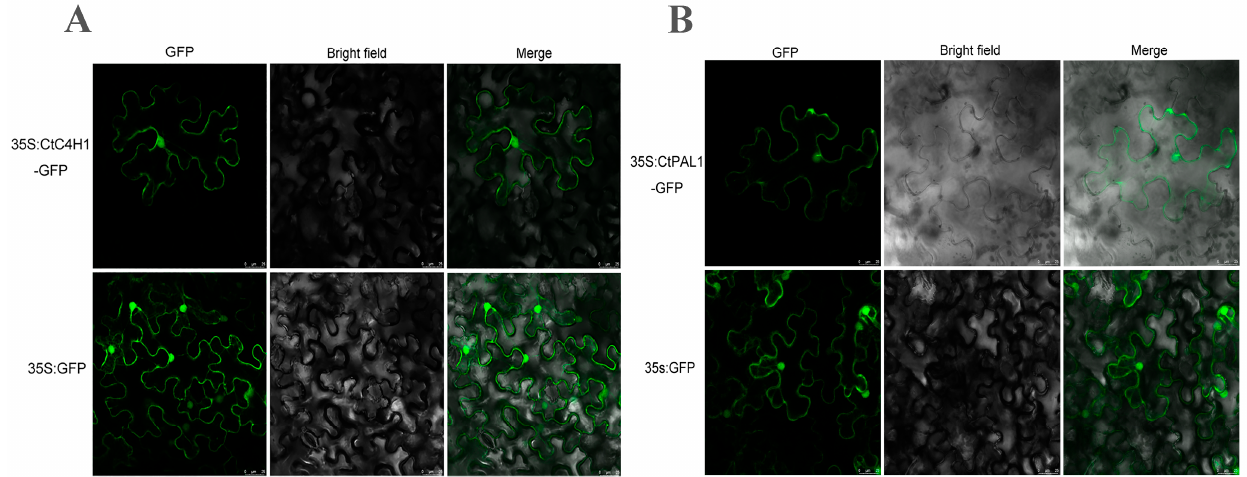
Figure 5. Subcellular location of CtC4H1 and CtPAL1 using GFP fusion constructs in tobacco leaves. ( A ) The green, fluorescent signals of the pCAMBIA1300-CtC4H1-GFP and ( B ) pCAMBIA1300-CtPAL1-GFP. The vector construct containing GFP alone was used as a control. Bars, 25 µ m.